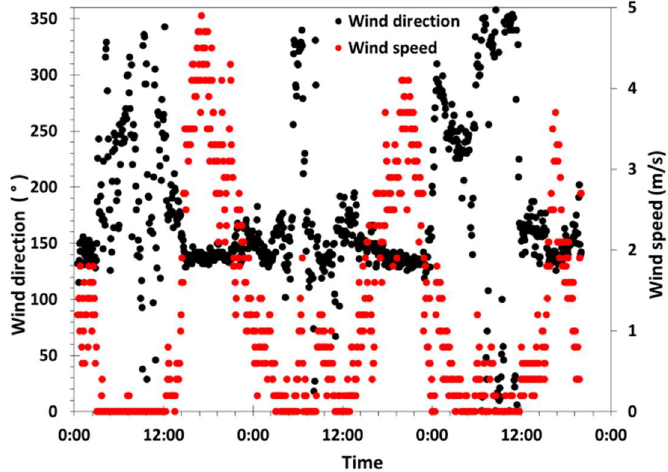
Figure 4. Wind directions and speeds at the coastal station (P0) measured between 22 January 2022 and 24 January 2022. Table 2. Global average and average oscillations of temperature and relative humidity values from 24 October 2021 to 18 June 2022.